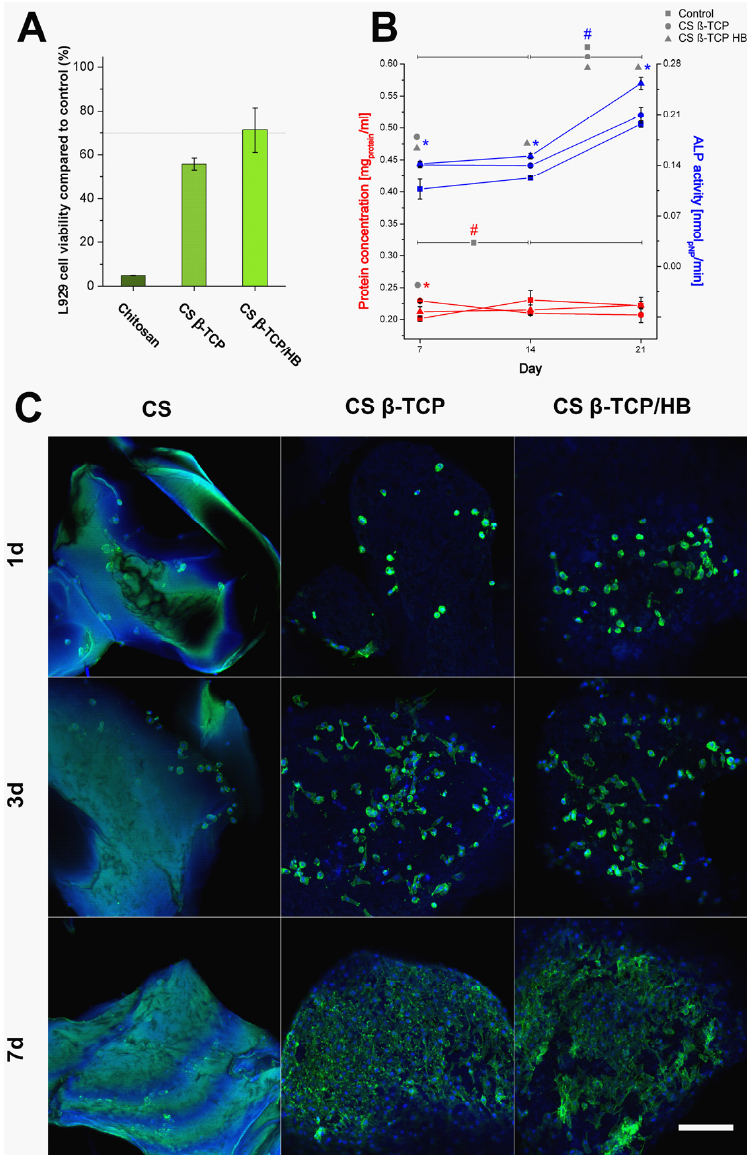
Figure 5. ( A )—cell viability assay. L929 cells viability cultured for 24 h on extracts and determined with XTT assay on extracts (ISO EN 10993-5). Error bars represent standard deviation ( n = 12). All means of viability are significantly different from each other ( p < 0.05). ( B )—alkaline phosphatase activity of control cells and granulates. ALP activity was measured in MG63 cell lysates, cells grown in 6-well plates with 20 mg of material per well. Total protein was determined with BCA assay. Asterisks (*) indicate significant differences ( p < 0.05) between the marked sample mean values and control in the same week, while number signs (#) indicate significant differences ( p < 0.05) between the marked sample mean values in time (weeks). ( C )—confocal microscopy images of MG63 cell cultures on prepared materials. Nuclei are stained blue by DAPI, while the cytoskeleton is stained green by Alexa Fluor 488™ Phalloidin. Scale bar—200 μ m.